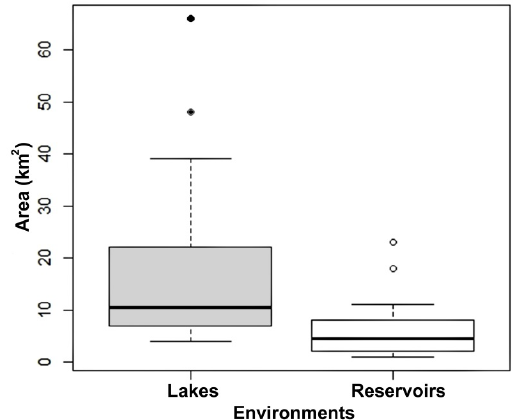
Figure 4. Boxplot of total species richness of microcrustaceans (copepods + cladocerans) in natural lakes (L) and reservoirs (R) until 6 km 2 of area. Clear circles are outliers.